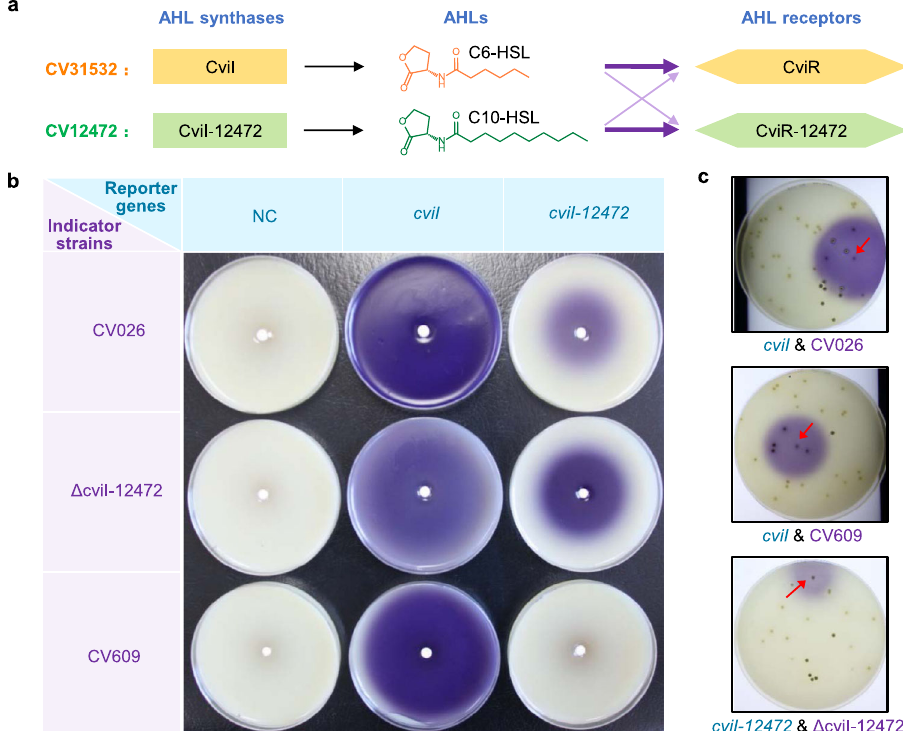
Fig. 6 Construction and validation of VRS-bAHLs with various sensitivities. a Schematic illustration of VRS-bAHL with different sensitivities. The construction of VRS-bAHL with different sensitivities was based on the cross-talk between the AHL QS signaling systems of CV31532 and another C. violaceum , CV12472, and the latter mainly employs long-chain AHL (C10-HSL) to induce violacein production. CV31532 and CV12472 can respond to AHLs from each other, but with lower sensitivities 60 . As a result, combinations of AHL synthase gene of CV31532 or CV12472 with different indicator strains (the AHL and violacein de fi cient mutants of CV31532 or CV12472) can generate a series of VRS-bAHLs with changeable sensitivities. b Detection and comparison of VRS-bAHL sensitivity. Two reporter genes, cviI and cviI-12472 , were constitutively expressed under the control of P hrdB on plasmid pIJ10500K in S. ansochromogenes 7100 and the AHL production was detected by double-layer plate method with three indicator strains (CV026, Δ cviI- 12472 and CV609), respectively. The derivative strains of S. ansochromogenes 7100 used here are as follows: AHL-producing strains, 7100OEcviI and 7100OEcviI-12472 (derivative strains of S. ansochromogenes 7100 containing cviI or cviI-12472 overexpression plasmid driven by P hrdB on pIJ10500K), and AHL-non-producing strain 7100NC ( S. ansochromogenes 7100 containing blank pIJ10500K). c A proof of concept experiment to investigate the application of VRS-bAHLs in colony screening. In brief, the spores of 7100OEcviI or 7100OEcviI-12472 were mixed with those of 7100NC at a ratio of 1/100 and the diluted mixtures were inoculated on MS agar medium. After cultivation for three days, double-layer plate method was applied to detect the colonies inducing violacein production, and the sensitivity of different VRS-bAHLs was compared. The VRS-bAHLs used for these tests are as follows: cvil & CV026 , cviI as the reporter gene and CV026 as the AHL indicator strain; cvil & CV609, cviI as the reporter gene and CV609 as the AHL indicator strain; cviI-12472 & Δ cviI-12472, cviI-12472 as the reporter gene and Δ cviI-12472 as the AHL indicator strain. The positive control in the mixture was indicated with red arrows. Data shown in b and c are representative of two independent experiments that displayed similar therefore promoting the discovery of natural products in Strep- tomyces and eventually many other microorganisms.